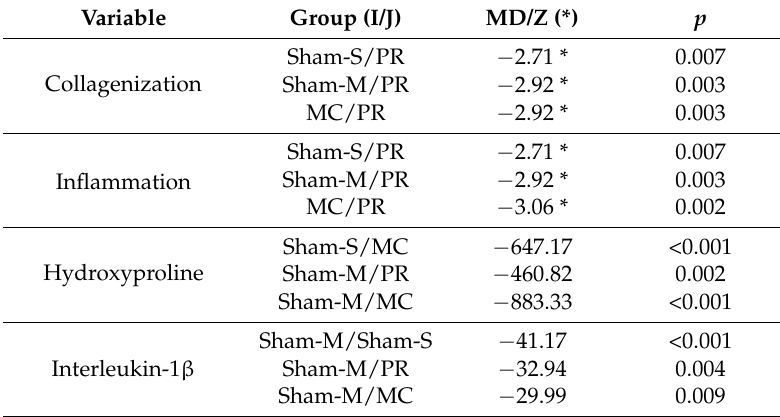
Table 4. Binary comparisons of the groups for histopathological and biochemical findings. Variable Group (I/J) MD/Z (*) p Sham-S/PR Collagenization